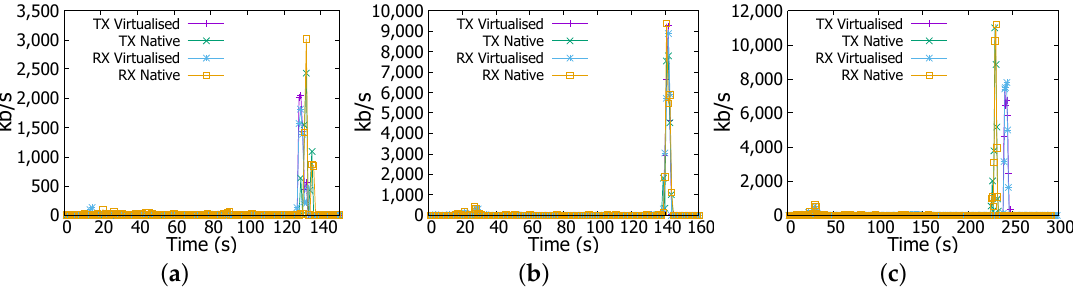
Figure 12. Transmission (TX) and reception (RX) rates in Sort job. ( a ) 1 GB file; ( b ) 4 GB file; ( c ) 6 GB